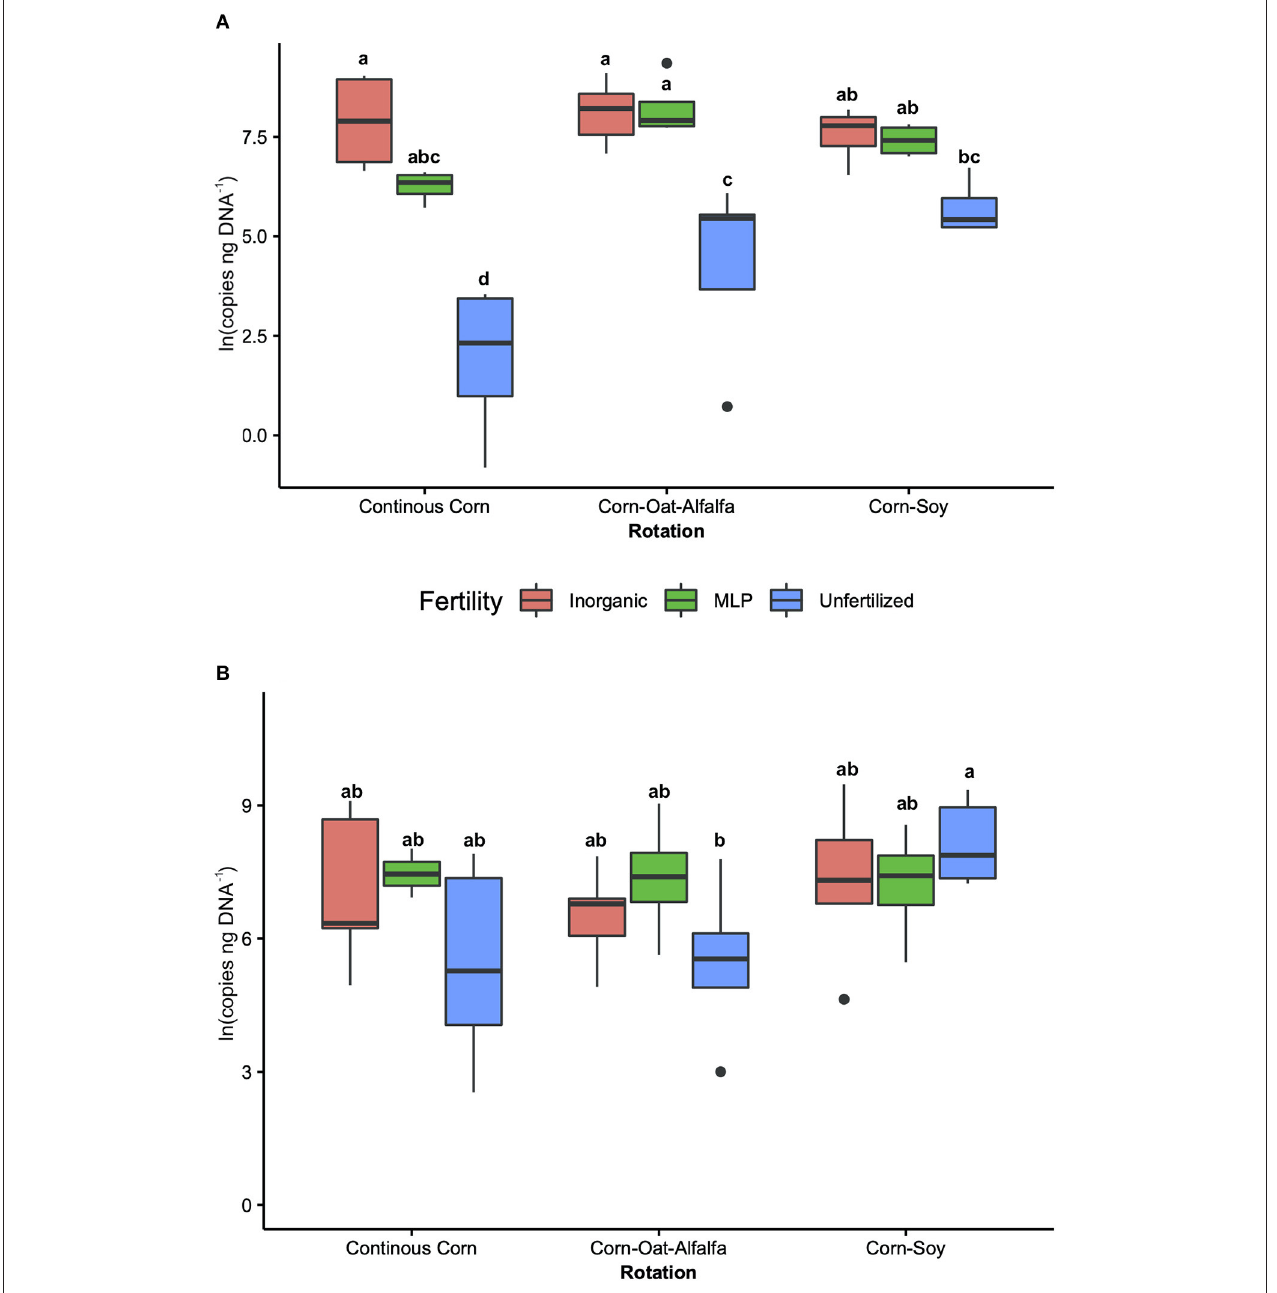
FIGURE 3 | Bacterial ( BamoA ) and archaeal ( AamoA ) shown in A and B , respectively, compared among long-term management treatments (fertility and rotation). Abundance, determined by amoA -specific qPCR, is reported as gene copy number/ng DNA. Tukey’s HSD was used for separations of group means, and group membership is indicated via lettering on top of each bar. 2-way ANOVA results are reported in Table 3 . Fertilization and rotational treatments are as follows: manure-lime-phosphorus (MLP), inorganic urea fertilizer (IN), unfertilized (UF); corn-oat-alfalfa (COA), corn-soy (CS), continuous corn